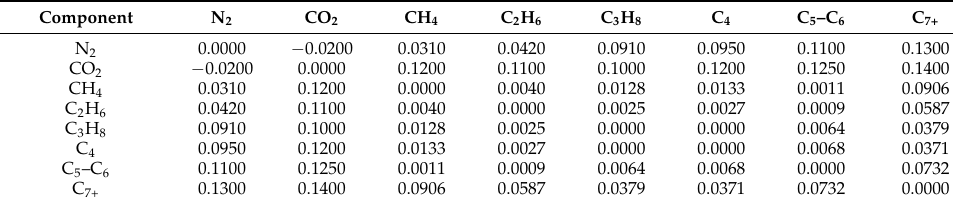
Table 2. Binary interaction parameters for the Duvernay volatile oil